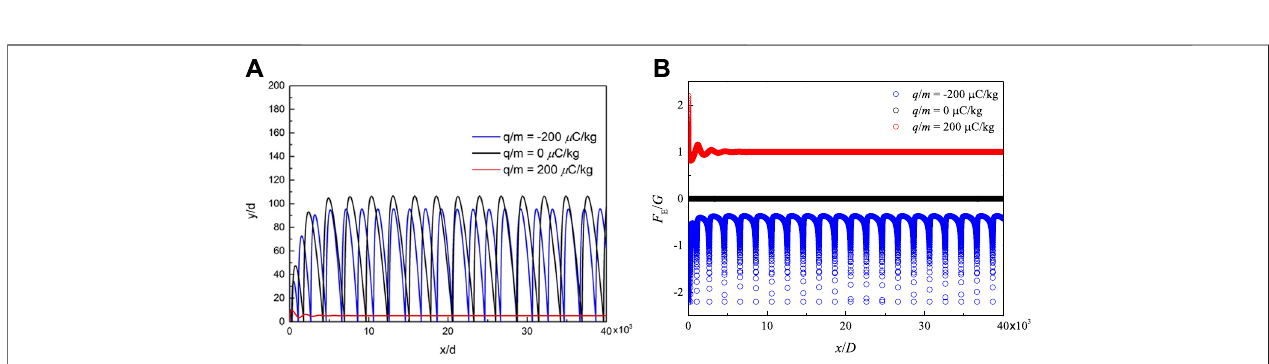
FIGURE 6 | (A) Trajectories of positive, neutral, and negative particles. (B) Ratio of electric force to gravity. The values of particles ’ charge to mass ratio are − 200 μ C / kg , 50 μ C / kg , and 200 μ C / kg .